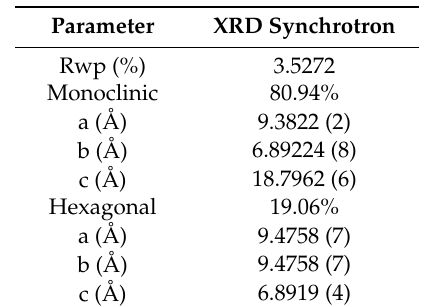
Table 1. Rietveld refinement and phase quantification of HA.